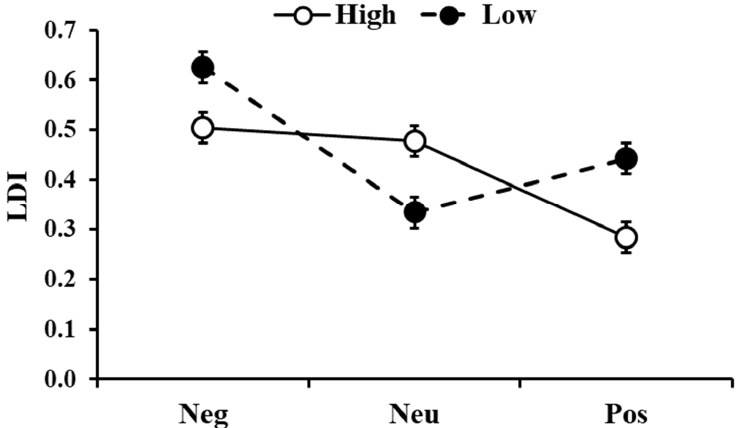
Figure 5. Lure discrimination index (LDI) as a function of the type of images (Neg: Negative, Neu: Neutral, Pos: Positive) and the similarity level (High and Low). The error bars represent the standard error of the means.